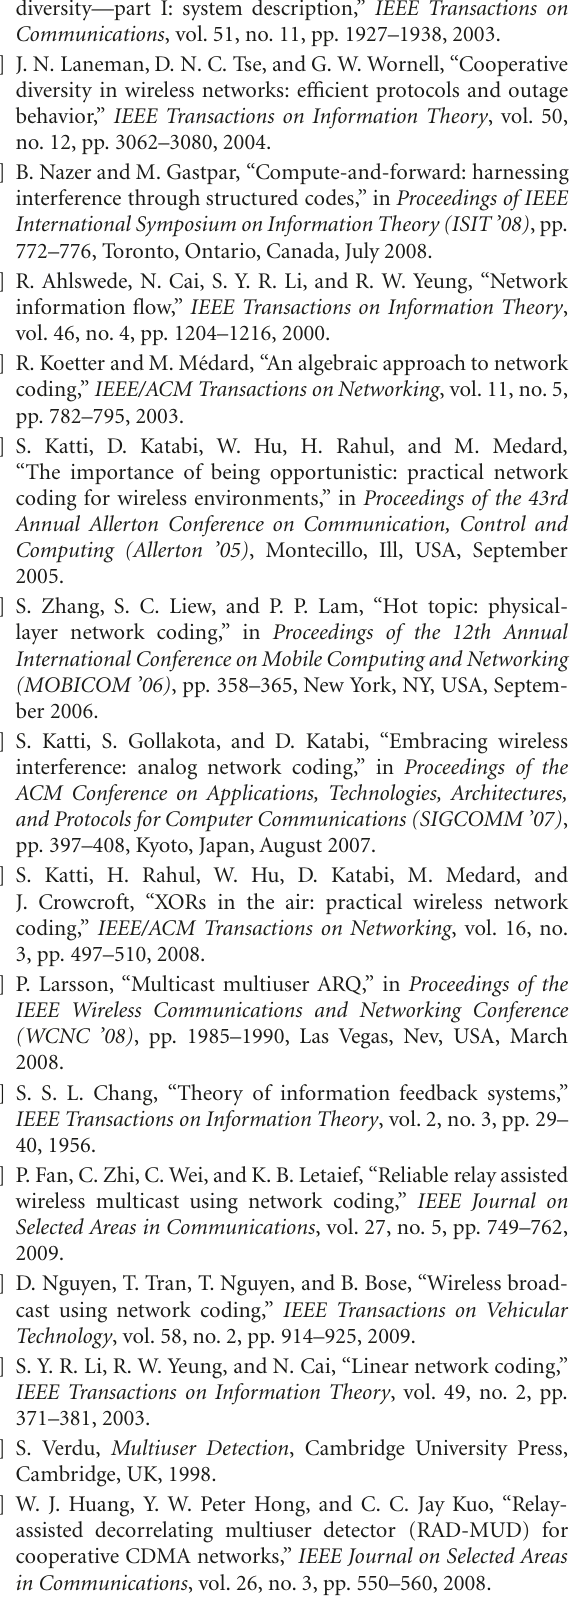
= p s = p s = with p s 1 d 1 2 d 2 1 d 2 2 d 1 p p p s 1 r = s 2 r , rd 1 = rd 2